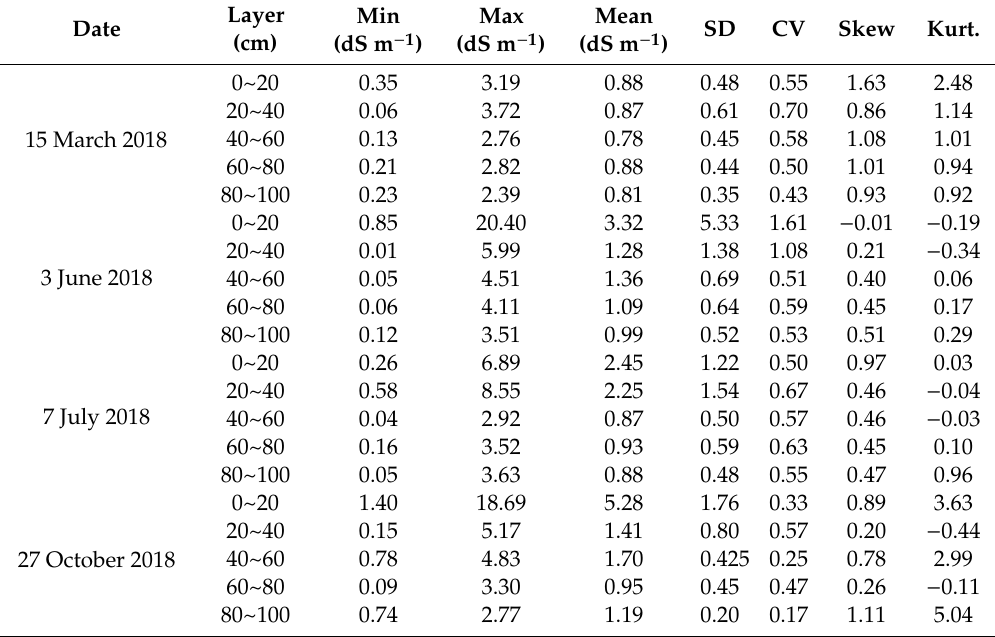
Table 4. The statistical characteristic values of soil salinity (ECe) attributes at di ff erent